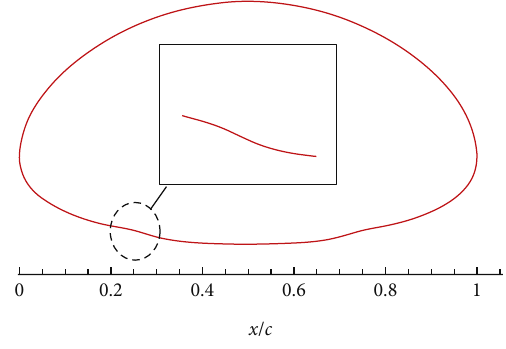
Figure 1: Pro fi le of DBLN-526 airfoil.